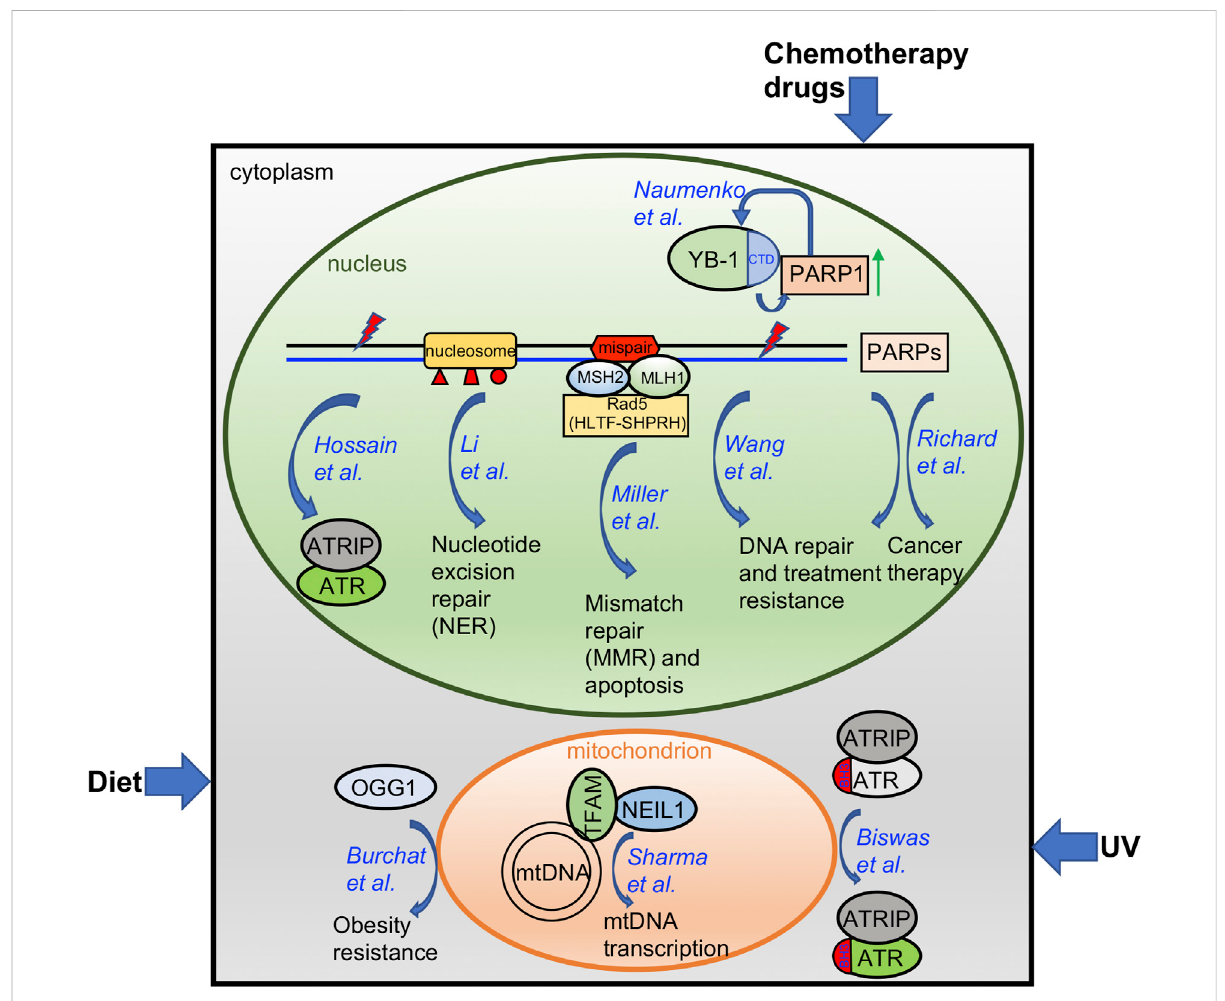
FIGURE 1 A diagram summarizing the fi ndings from papers included in this Research Topic. Please see text for more